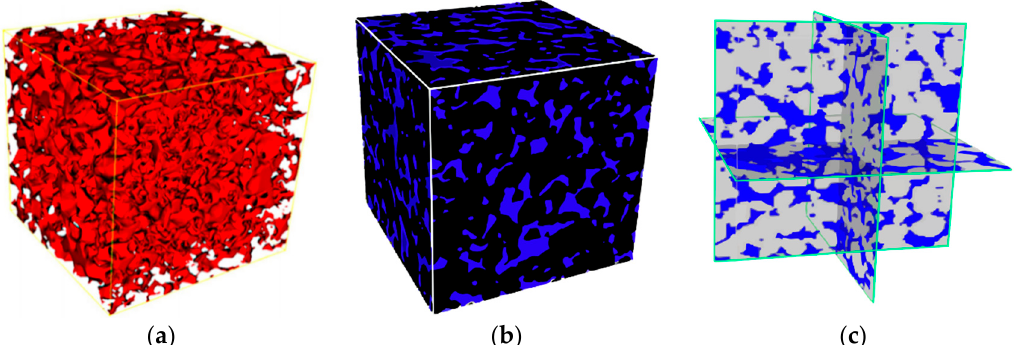
Figure 4. Pore network model. ( a ) Skeleton model, ( b ) skeleton and pore, and ( c ) sectional view of the pore.